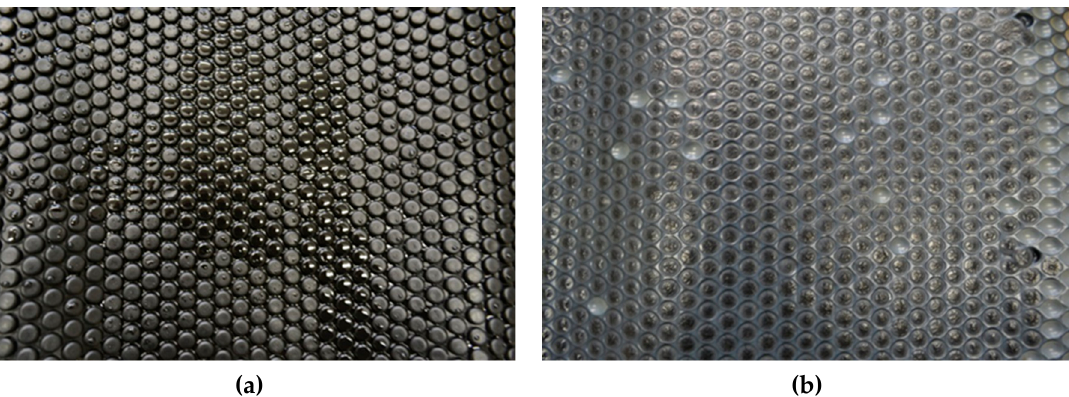
Figure 1. Phase change materials (PCMs) encapsulated in bubble foil: ( a ) View of liquid PCMs on the surface; ( b ) Empty and deformed bubbles with visible solid PCMs on the surface.